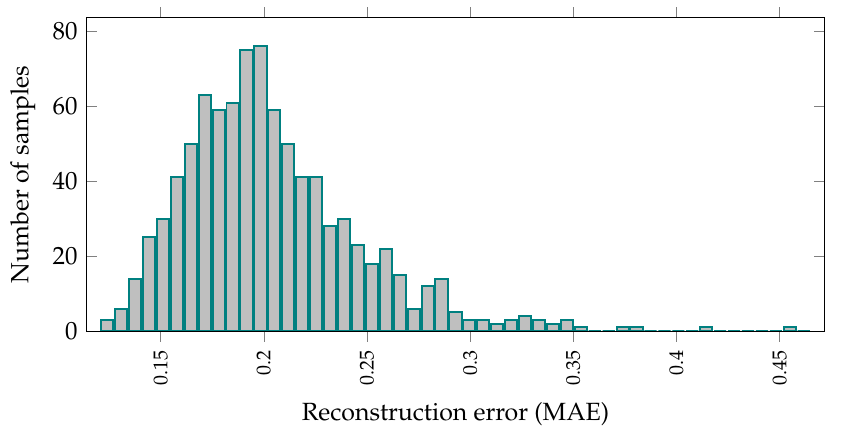
Figure 6. Distribution of reconstruction error given the normalized input data. For the binary classification case, given these data, a threshold can be determined for